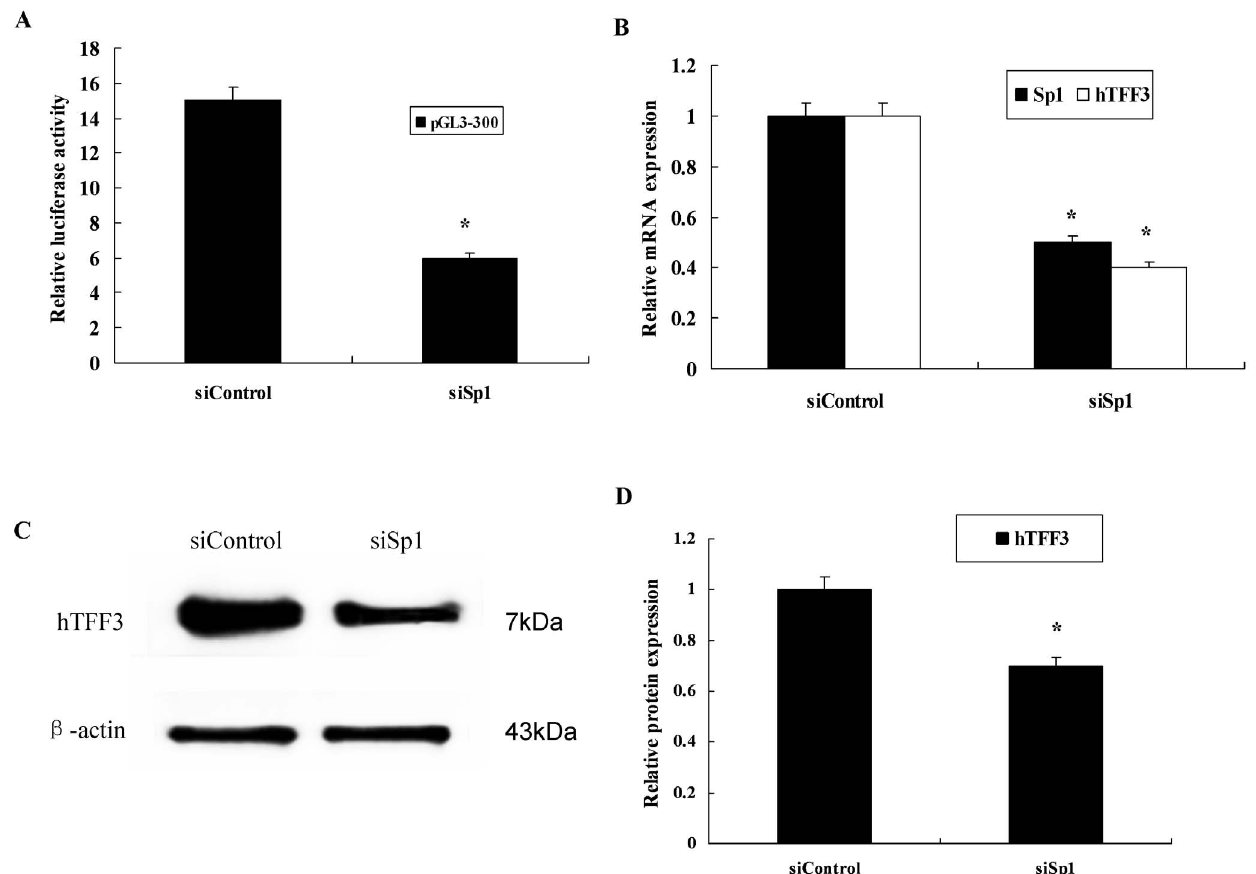
Figure 6. The effect of Sp1 down-regulation on transcription from the hTFF3 promoter. pGL3-300, pRL-TK, and Sp1 siRNA or non-targeted control siRNA were co-transfected into LS-174T cells and cultured for 48 h. A. Relative luciferase activity (*P , 0.05 vs . SiControl). B. Detection of Sp1 and hTFF3 mRNA levels by real-time PCR (*P , 0.05 vs . SiControl). C and D. Detection of hTFF3 protein by western blotting.